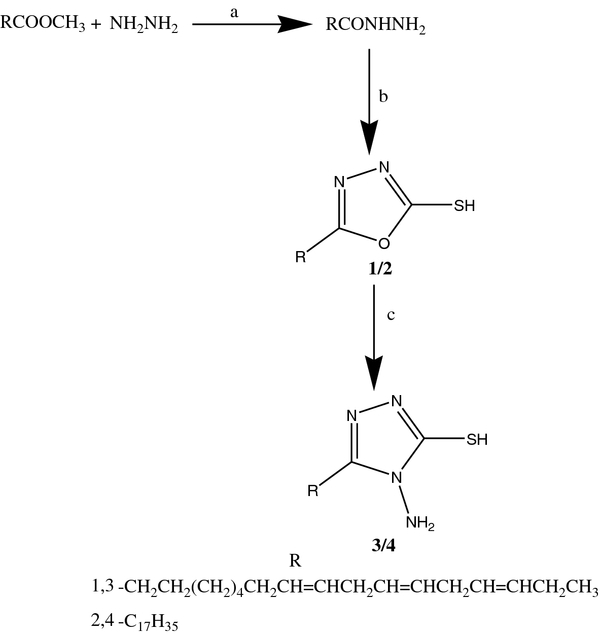
Synthesis of the compounds. Reagents and conditions. a) NH2NH2, reflux 8 h. b) POCl3, C17H35COOH, reflux, 8 h, neutralization with NaOH, c) NH2NH2, reflux, 8 h, acidification with HCl upto pH3.